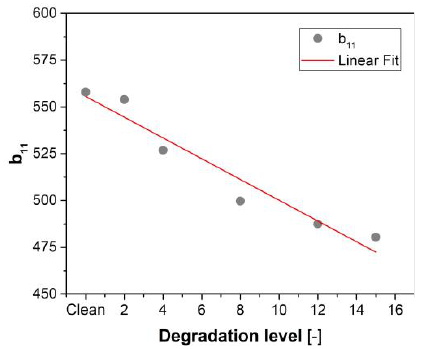
Figure 6. Coefficient b 11 computed from linearization for different levels of compressor degradation (dots) and the linear fit